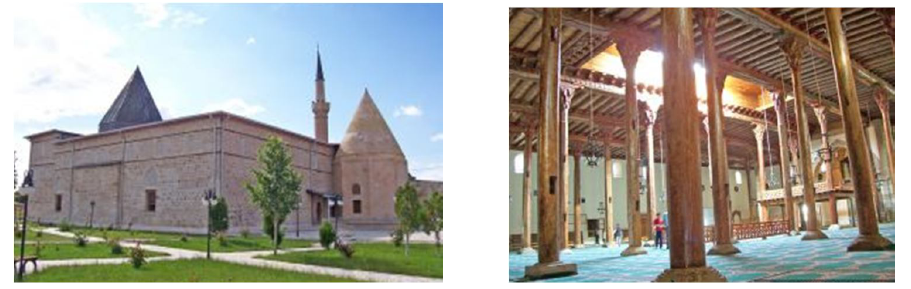
Picture 1: The Exterior of the Mosque Picture 2: Interior of the